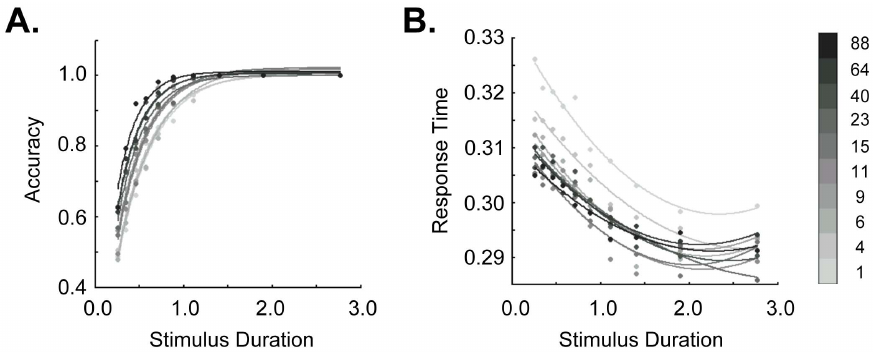
Figure 2. Behavior. All trials were divided by both motion coherence and duration into a total of 100 (10 6 10) bins. A. Accuracy increased with both increasing duration and increasing motion coherence. Curves represent the best-fitting exponential. B. Response time declined with both increasing duration and increasing motion coherence. Curves represent the best-fitting second-order polynomial.